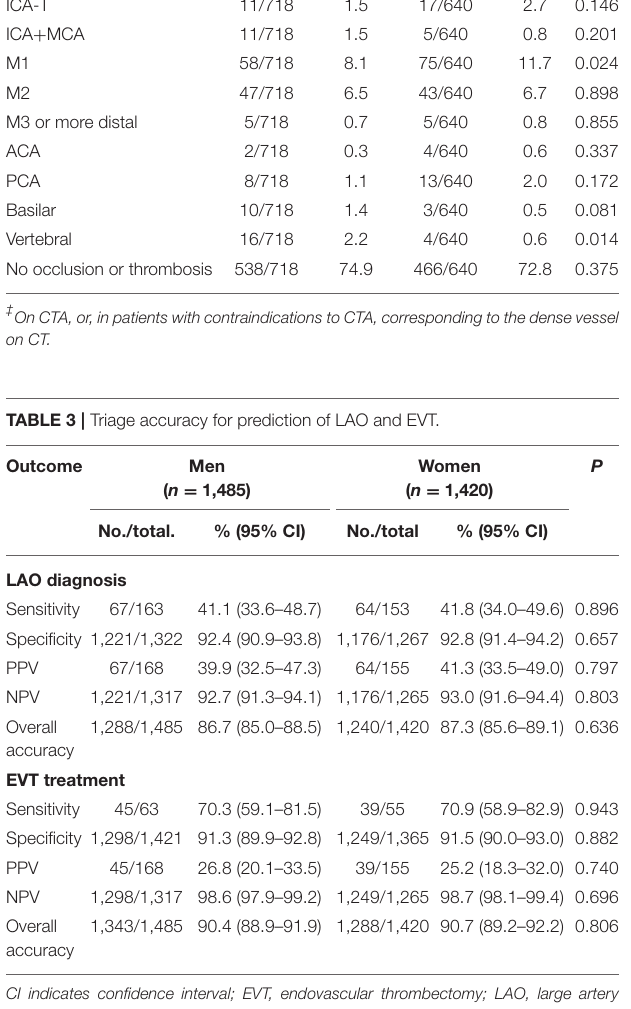
( Table 2 ), the absolute differences were modest, e.g., MCA M1